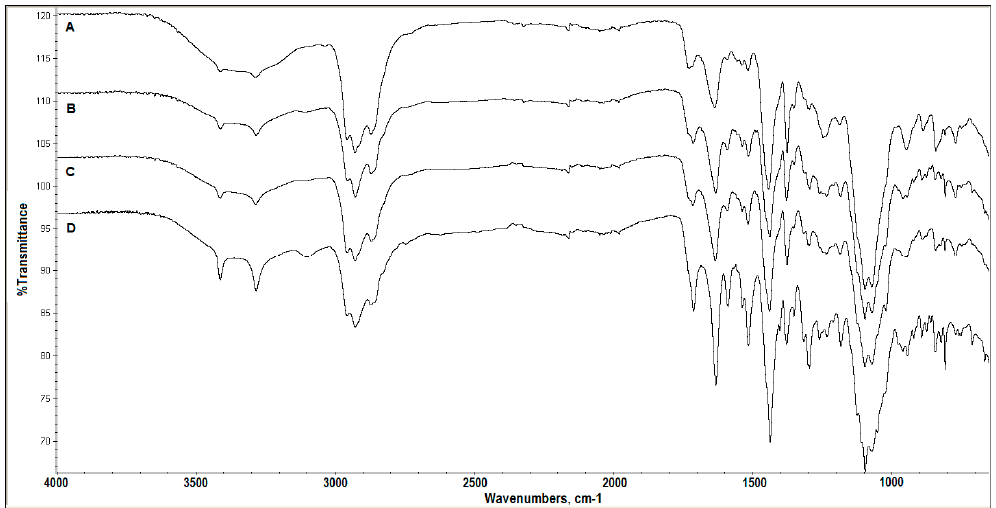
Figure 8. Typical FTIR spectra of the catheter with SPA immobilized from solutions with increasing SPA concentrations: 0.1 ( A ), 0.5 ( B ), 1.0 ( C ), and 2.0 ( D ) mg/mL (SPA-M3 method).